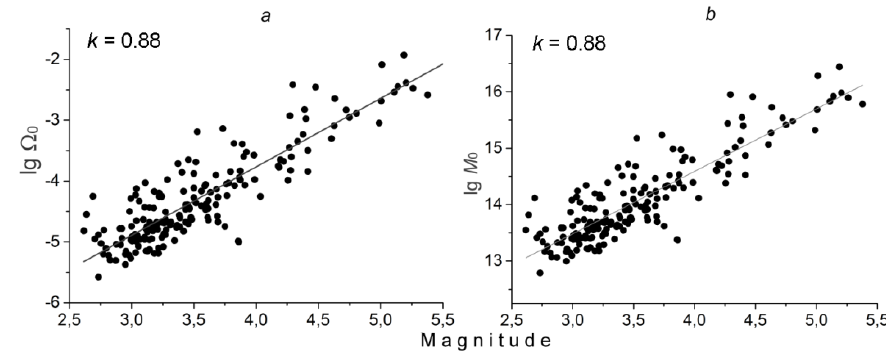
Fig. 6. Logarithmic distributions of spectral density ( a ) and scalar seismic moment ( b ) versus magnitude. k is the correlation